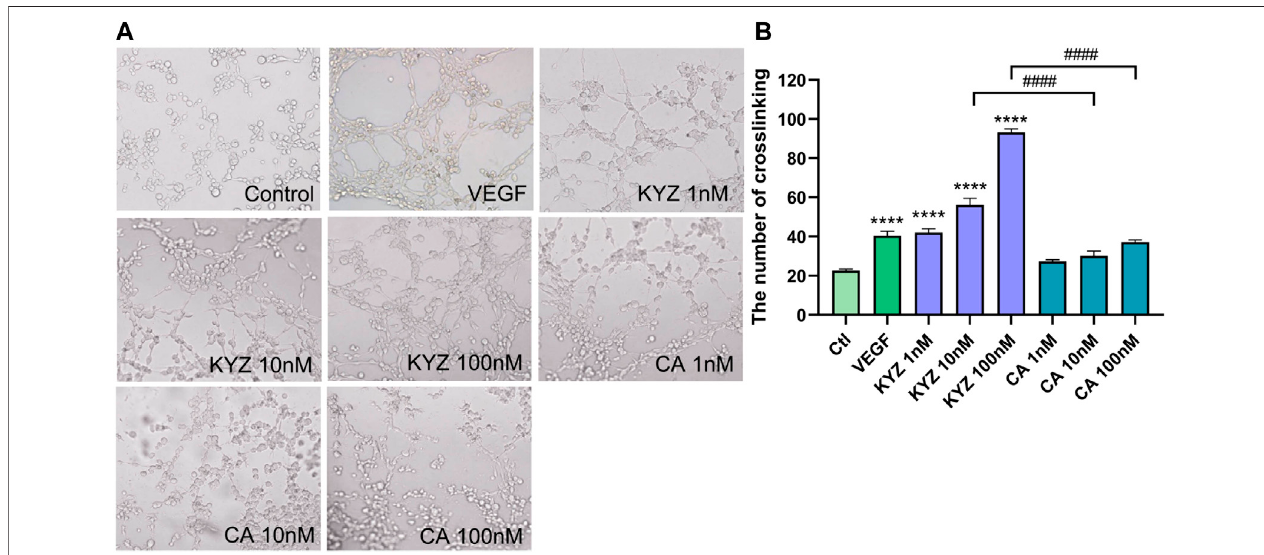
FIGURE 7 | The KYZ treatment enhanced tube formation of HUVECs. (A) The HUVECs were pretreated with difference concentration KYZ and CA for 24 h, then the cells were cultured on the Matrigel. After treatment for 8 h, the tube structure was photographed, and the photomicrographs were shown at × 4 magni fi cation, and thenumberoftubejunctureswerecounted. (B) QuantitativeanalysisthenumberoftubejuncturesineachgroupbyImageJsoftware.Theresultswereshownasmean± SEM. Statistical analysis was performed using a one-way analysis of variance, n = 3. *** p < 0.001,**** p < 0.0001 vs. control.